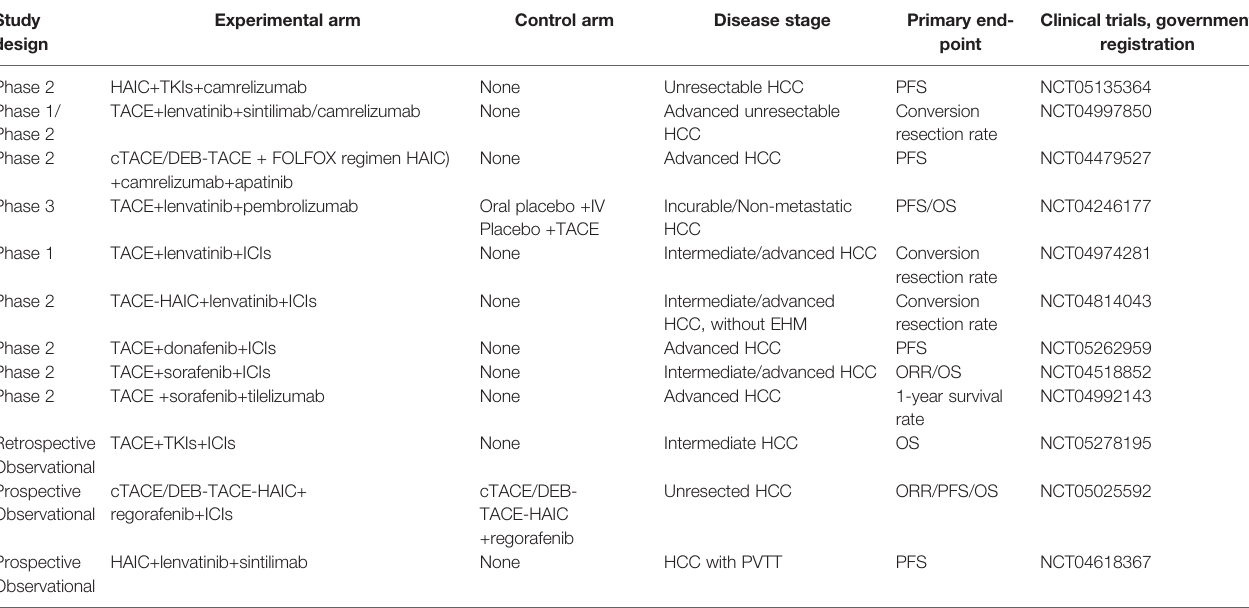
TABLE 7 | Ongoing clinical trials for triple